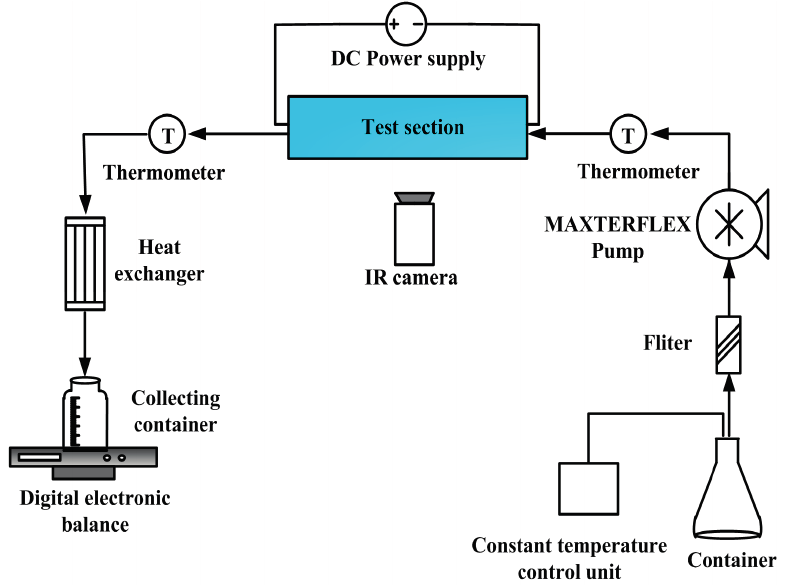
Figure 6. Schematic of the experimental